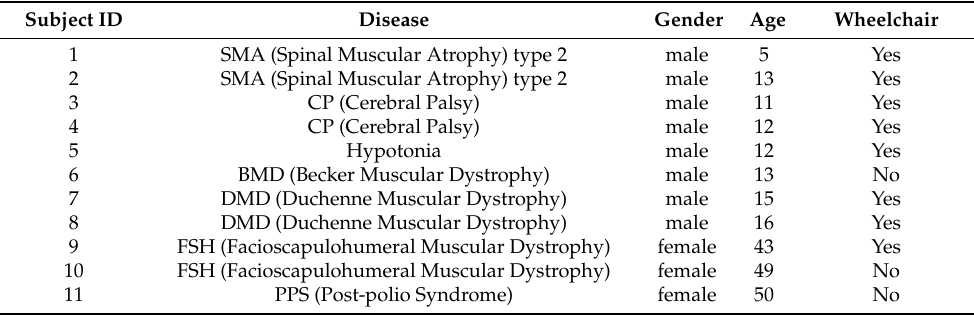
Table 1. Overview of volunteers. Subjects 1, 2 and 4 (grey) are not included in the evaluation as their wheelchairs produced detection